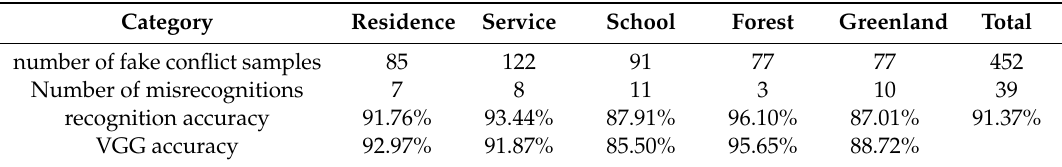
Table 7. Contrast between the VGG accuracy and the MS-LSTM + VGG accuracy.